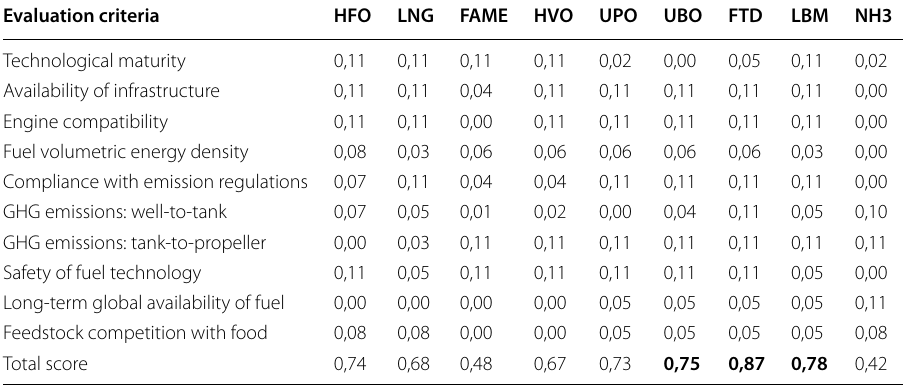
Table 5 Total SMART score of each alternative i for the average, unregulated, 2020 scenario Evaluation